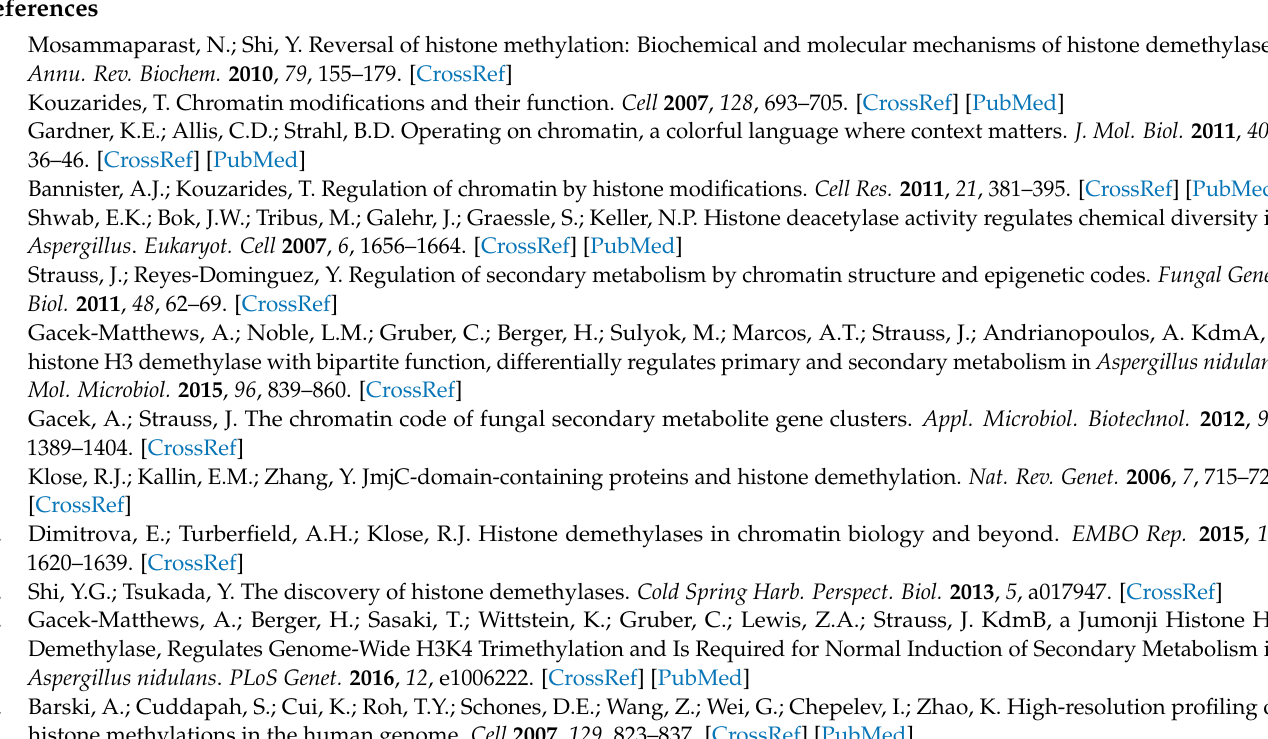
Table S4: Primary metabolic process-related genes that regulated differentially in ∆ kdmA and ∆ kdmB strain compared to WT